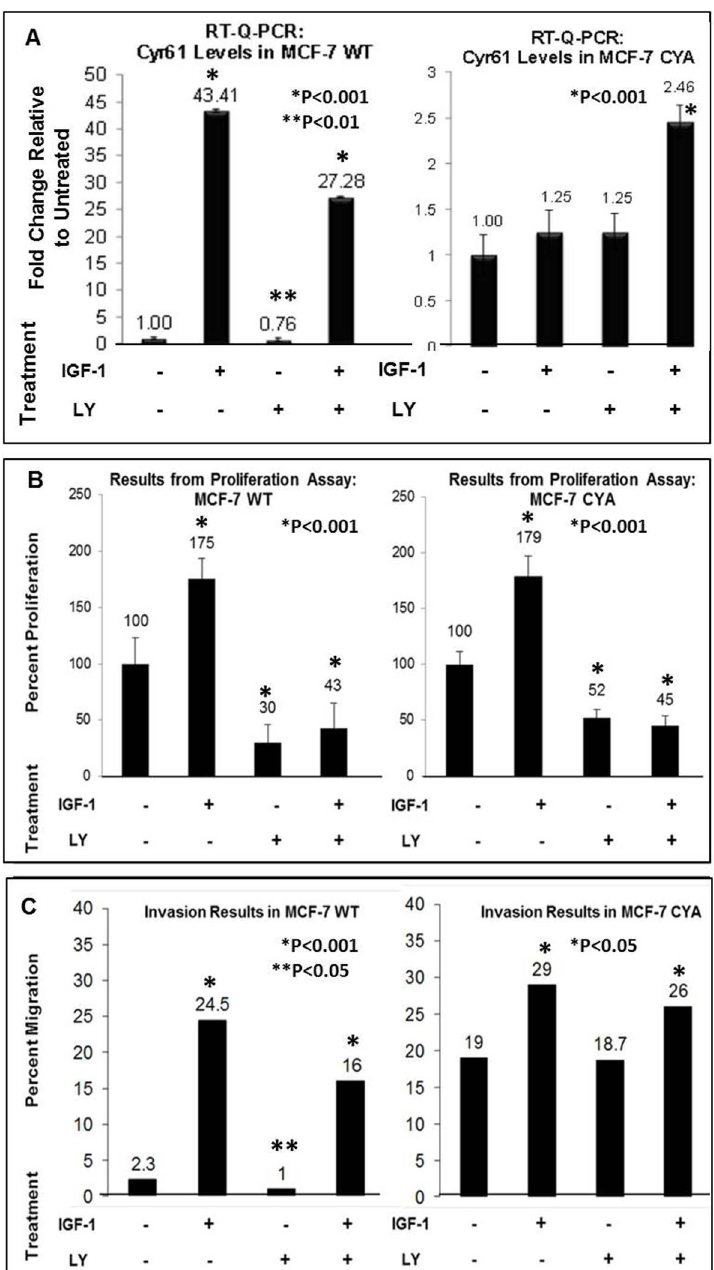
Figure 3. Effects of IGF-1 and LY294002 Induction on Proliferation, Invasion, and Cyr61 Expression in MCF-7 WT and CYA. ( A ) The mRNA expression of Cyr61 was assessed by RT-Q-PCR. All mRNA levels were adjusted for the housekeeping gene, 18S. ( B ) Results from proliferation assay after 48 hour IGF-1 (100 ng/mL) and LY294002 (50 m M) treatment in MCF-7 WT and MCF-7 CYA. Each condition was plated into 6 identical wells in a 96 well plate. All treatments were standardized relative to the untreated condition for each cell line. ( C ) Results from Invasion assay after 40 hour IGF-1 (100 ng/mL) and LY294002 (50 m M) treatment in MCF-7 WT and MCF-7 CYA. P-values were assessed relative to the untreated condition in each assay, with P , 0.05 considered statistically